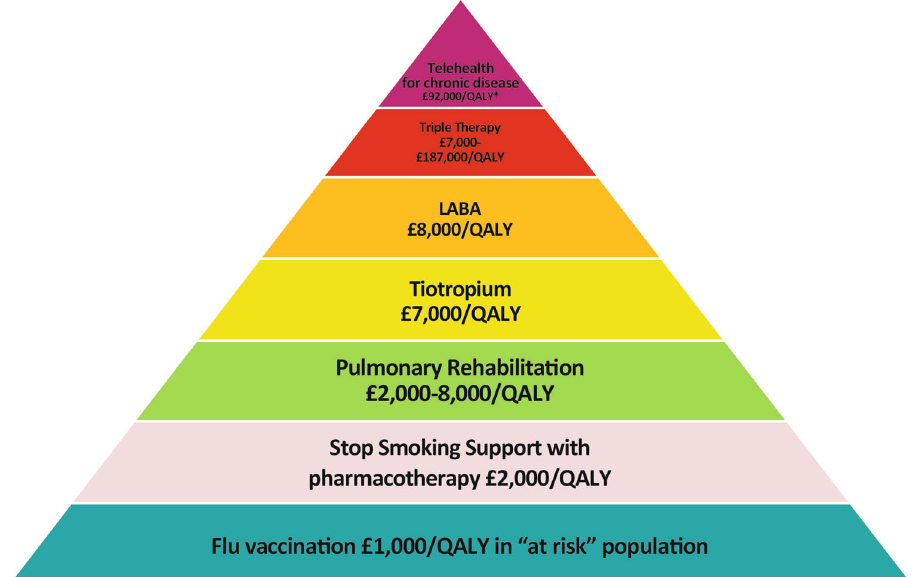
Fig. 2 The pyramid of value for COPD interventions.The pyramid of value for COPD interventions developed by the London Respiratory Network with The London School of Economics (reproduced from 22 ) gives estimates of cost per quality-adjusted life year gained. LABA long- acting β 2 agonist, QALY quality-adjusted life year